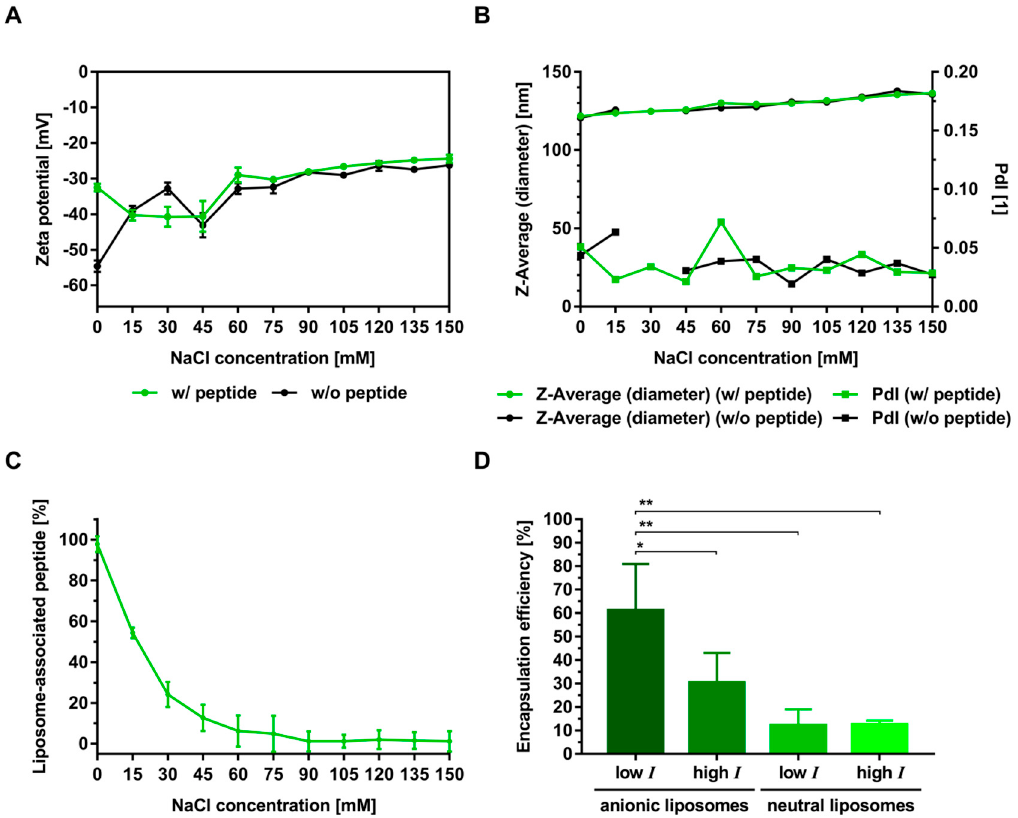
Figure 4. ( A , B ) Electrostatically driven binding and encapsulation of OVA 323-339 2K. ( A ) Zeta potential and ( B ) Z-Average / PdI of anionic liposomes in the presence (w / peptide) and absence (w / o peptide) of OVA 323-339 2K. Data represent the mean ± standard deviation from three analytical replicates. Measurements with peptide were performed at a molar peptide:lipid ratio of 1:133 (3 µM peptide, 400 µM lipid). ( C ) Binding to anionic liposomes at a molar peptide:lipid ratio of 1:133 (50 µM peptide, 6.67 mM lipid). Unspecific binding to the ultrafiltration membrane at 0 mM NaCl and 150 mM NaCl was determined to be 13.1 ± 2.4% and 6.2 ± 2.8%, respectively. ( D ) Encapsulation efficiency